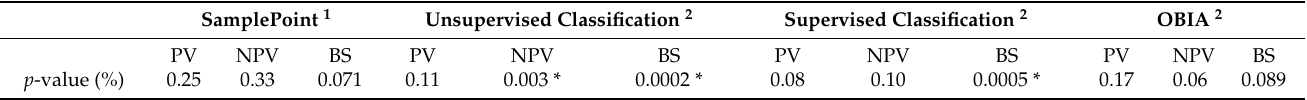
Table 2. p -value of the paired-samples Wilcoxon test between in situ assessment and four other approaches (SamplePoint estimation, unsupervised classification, supervised classification, and object-based image analysis (OBIA)). SamplePoint